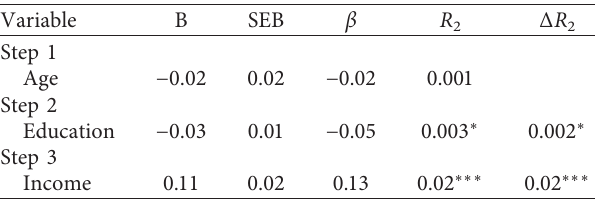
Table 5: Hierarchical regression analysis for variables predicting spirits beliefs ( N �